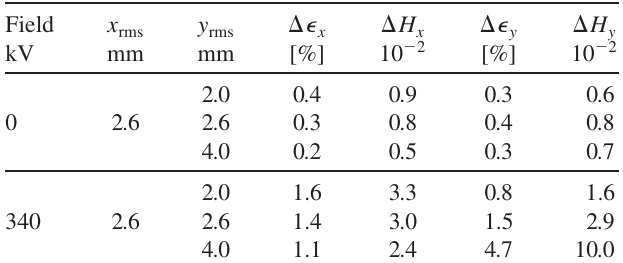
TABLE IX. Aspect ratio dependence—uniform beam (paral-